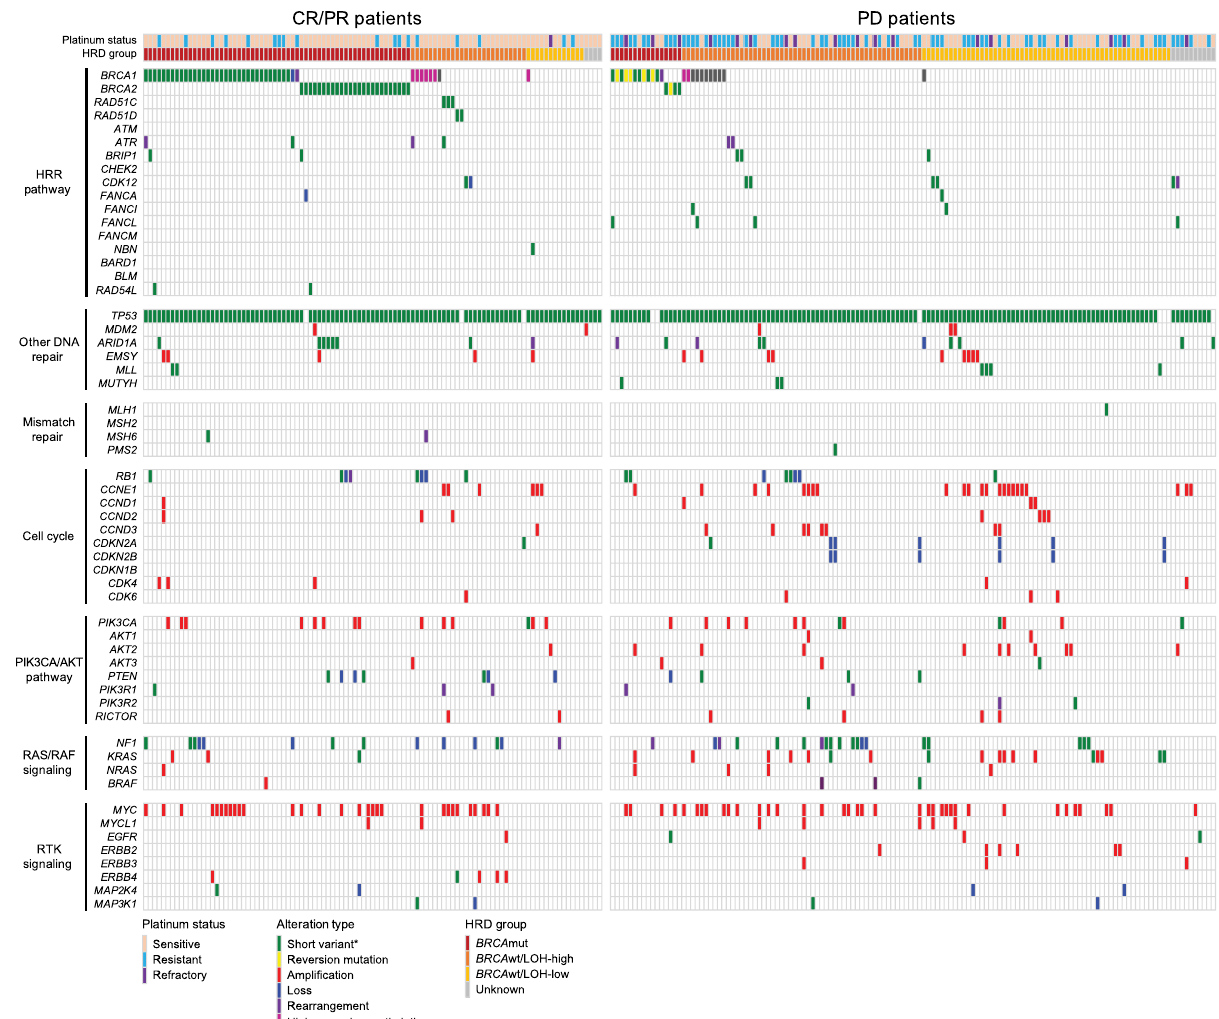
Fig. 4 Genetic and epigenetic alteration landscape of HGOC with con fi rmed best response of CR/PR (left) or PD (right). Methylation levels shown are at screening. *Short variant include nonsense, missense, frameshift, and splice site alterations. All reported alterations are deleterious or likely deleterious. BRCA BRCA1 or BRCA2 , CR complete response, HGOC high-grade ovarian carcinoma, HRR homologous recombination repair, LOH loss of heterozygosity, mut mutated, PD progressive disease, PR partial response, RTK receptor tyrosine kinase, wt wild